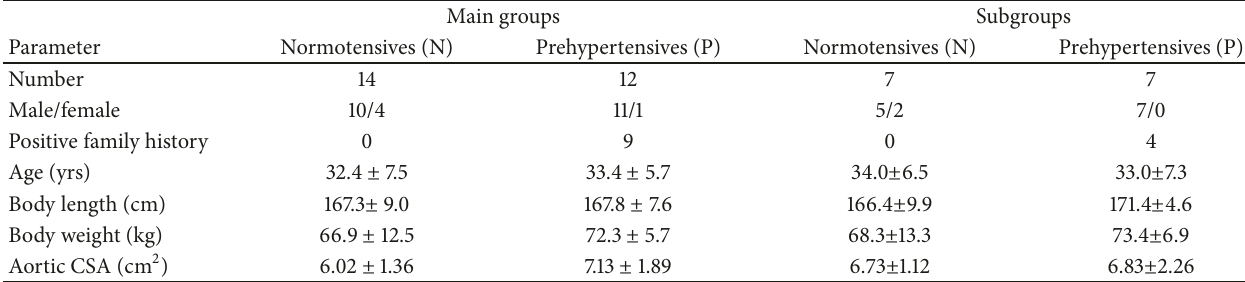
Table 1: Clinical characteristics (mean ± SD) of the entire study population comprised of the N and P main groups and